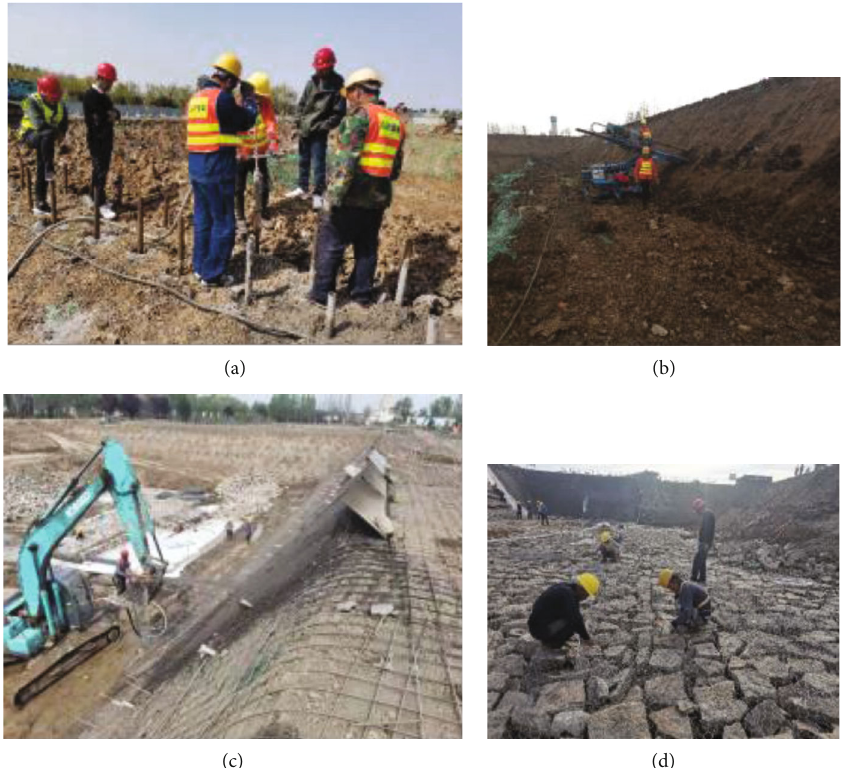
Figure 10: Site construction of boat pond reinforcement: (a) curtain grouting; (b) excavation and back fi lling of foundation pit; (c) slope support; (d) boat pond